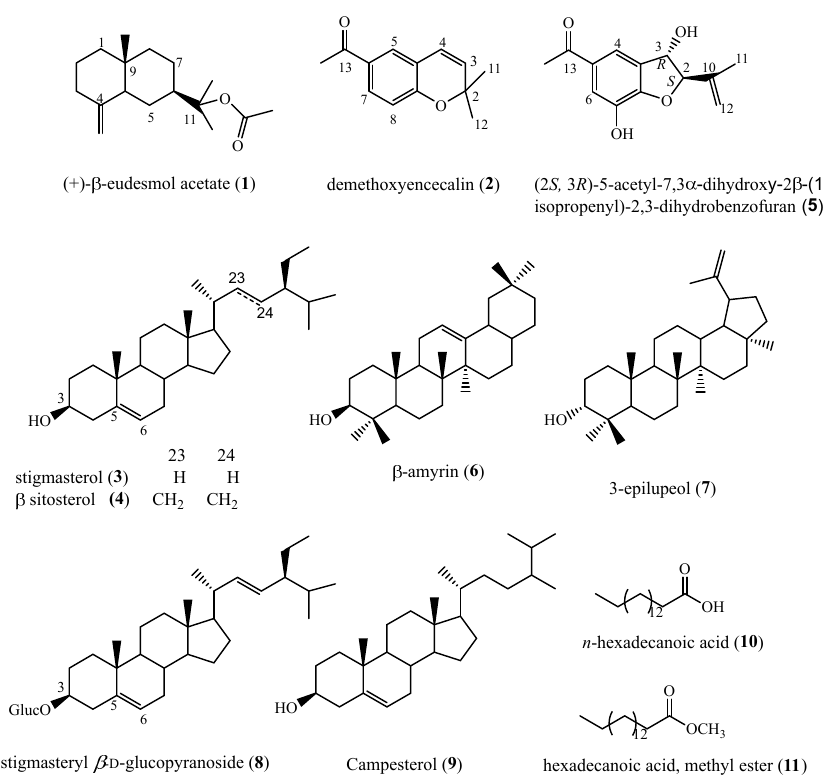
Figure 2. Chemical structures of compounds isolated from callus culture of A. pichinchensis.